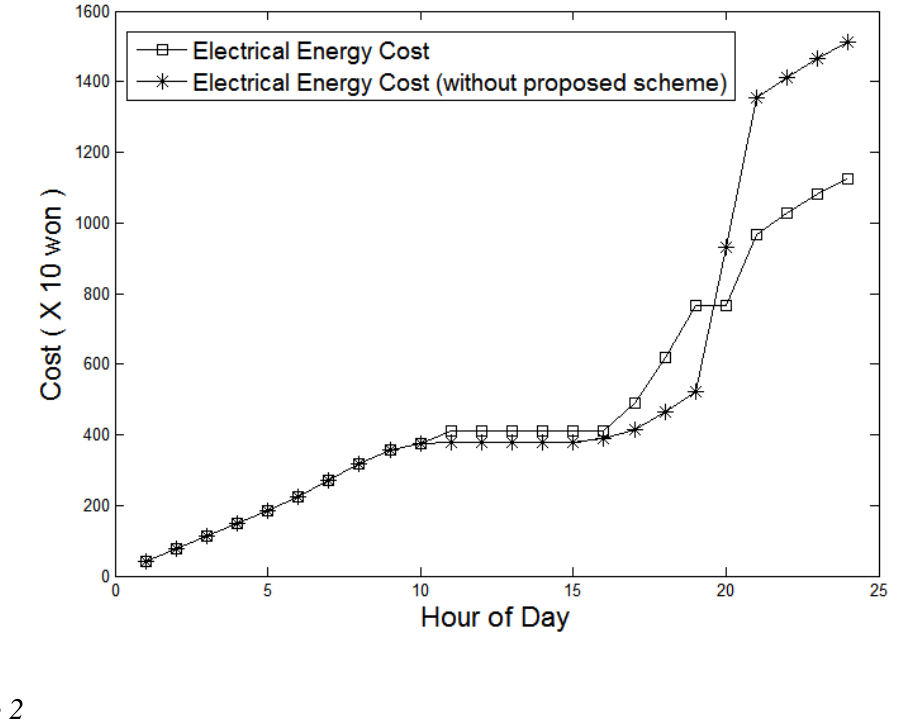
Figure 14. Comparison of electricity prices in Scenario